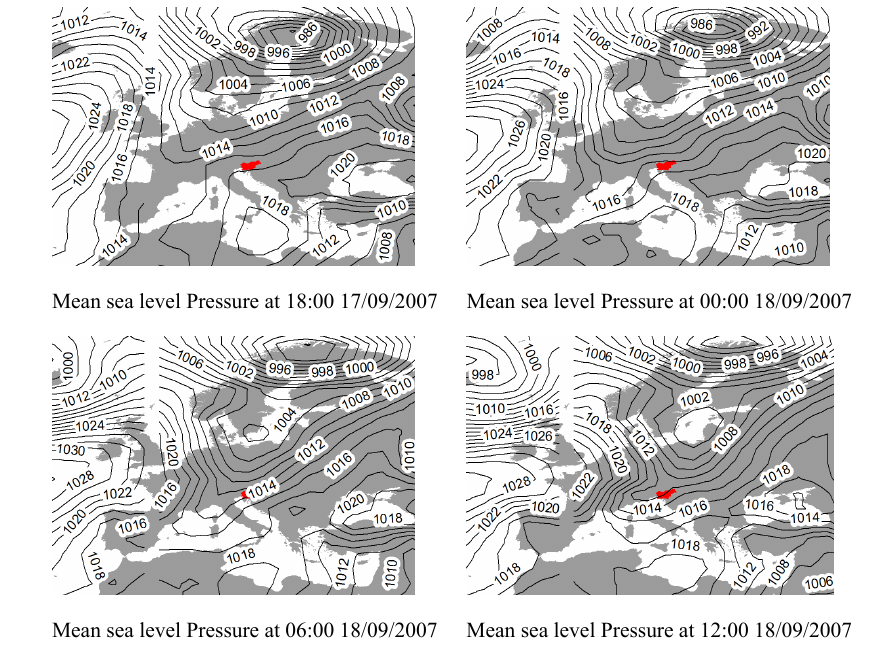
Figure 2: Mean sea level pressure for September 17 - 18, 2007 over Europe. The depression 1 Fig. 2. Mean sea-level pressure for 17–18 September 2007 over Europe. The depression over Northern Europe is interpreted clearly at over Northern Europe is interpreted clearly at 17/9/2007 18:00, when it moved to central 2 17/9/2007 18:00, when it moved to central Europe. At 18/9/2007 06:00 it clearly moved southward while at 12:00 it passed over the Slovenia (marked in red). Europe. At 18/9/2007 06:00 it is clearly moved southern while at 12:00 it passed over the 3 Slovenia (marked in red). 4